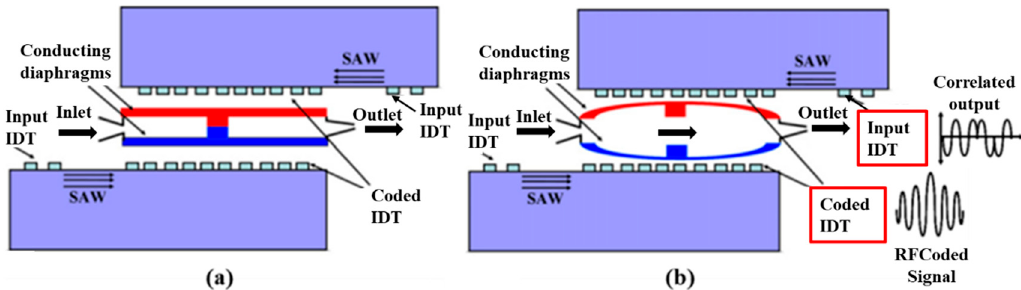
Figure 20. A SAW Microvalve in ( a ) the OFF/normally closed state; ( b ) the ON/open state [122]. Many microvalves based on SAW are utilized to for the purpose of secure wireless actuation.